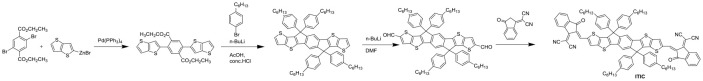
Synthetic route of ITIC.